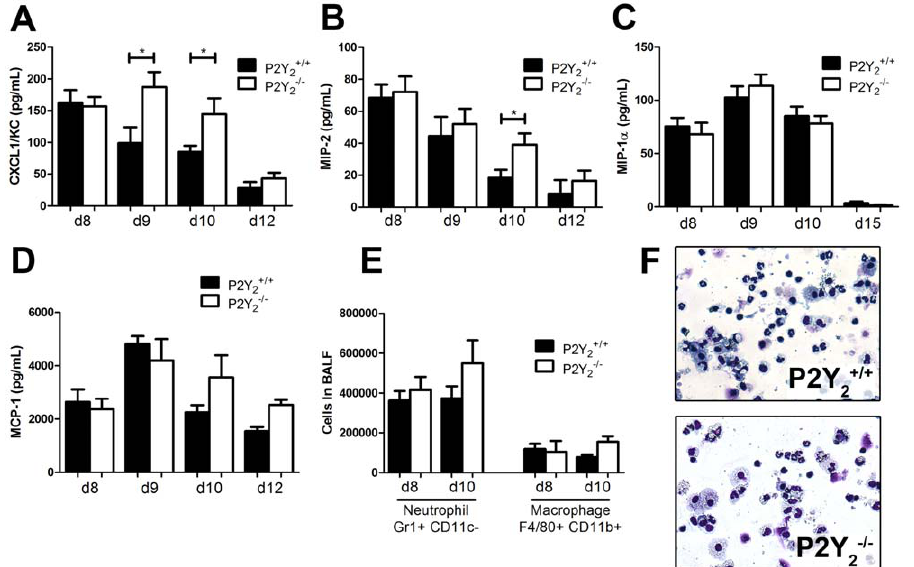
Figure 3. Quantification of neutrophils and macrophages, and their recruiters in the lungs of PVM-infected P2Y 2 + / + and P2Y 2 2 / 2 mice. A–D. The level of the chemokines KC/CXCL-1 (A), MIP-2/CXCL-2 (B), MIP-1 a /CCL3 (C) and MCP-1/CCL2 (D) was determined by ELISA in the BALFs of PVM-infected P2Y 2 + / + and P2Y 2 2 / 2 mice. (N=9) E. Flow cytometry quantification of neutrophils and macrophages in the BALFs of PVM- infected P2Y 2 + / + and P2Y 2 2 / 2 mice at day 8 and 10 post-inoculation (N=12). F. Cytospin preparations were made from BALFs of P2Y 2 + / + and P2Y 2 2 / 2 mice at day 8 post-infection using a Shandon III cytocentrifuge and were stained using Diff-Quick staining. Magnification: 6